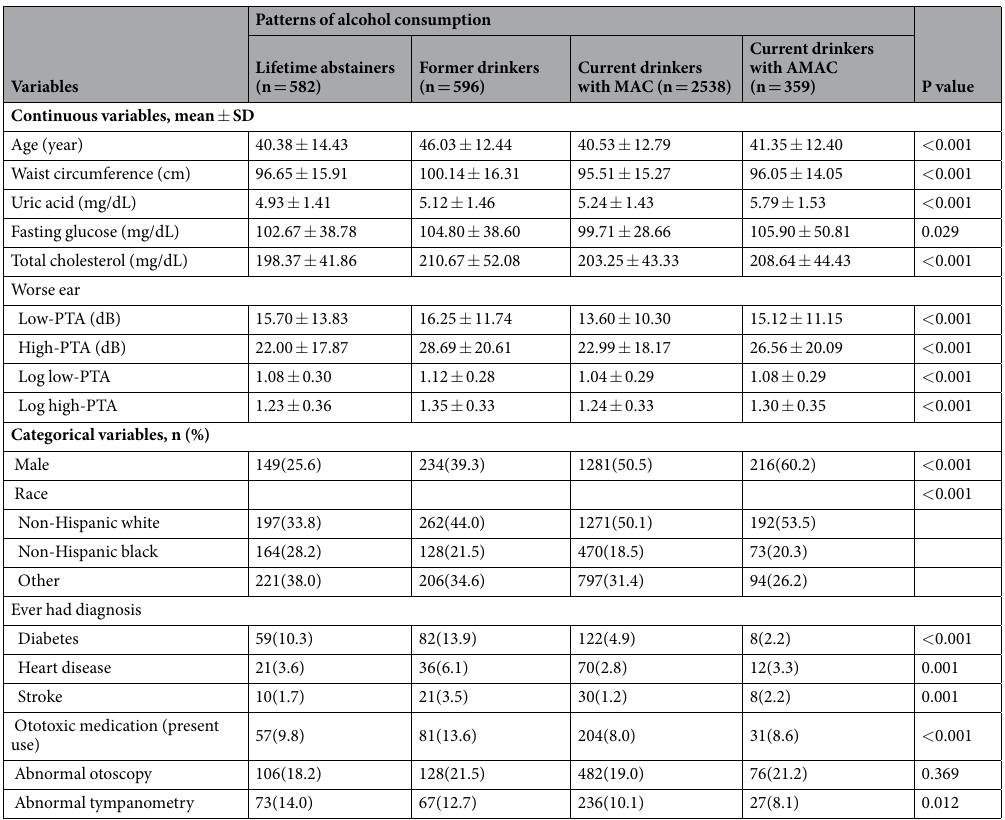
Table 1. Characteristics of study participants. Definition of abbreviations: MAC = moderate alcohol average at low frequencies. High-PTA = Pure tone average at high